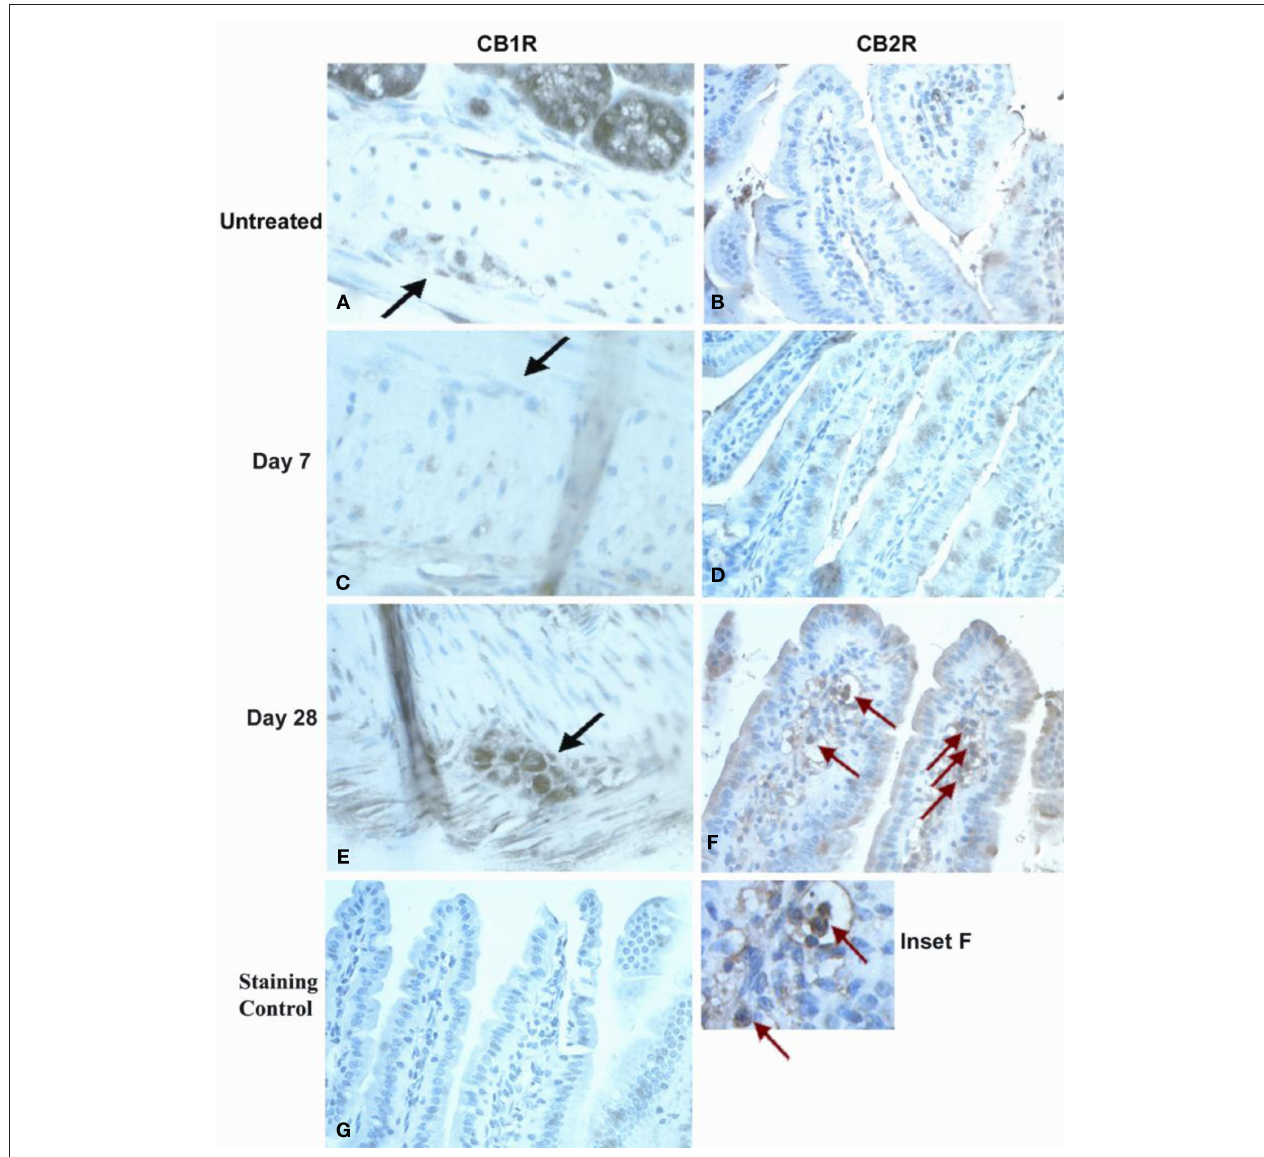
Figure 1 | immunohistochemical staining of small intestine tissues for CBr expression. Neuronal staining in myenteric plexus in normal controls (A) , day 7 post-OM (C) and day 28 post-OM (e) . Black arrows indicate myenteric ganglia. Moderate staining was observed in normal controls, deeply reduced at day 7, and restored to higher levels of expression at day 28. Immunohistochemical staining of small intestine tissues for CB2R expression is